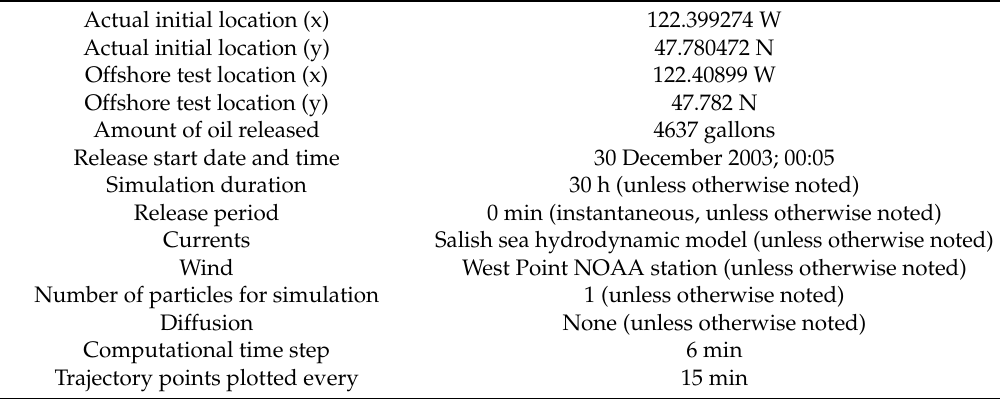
Table 2. Baseline simulation